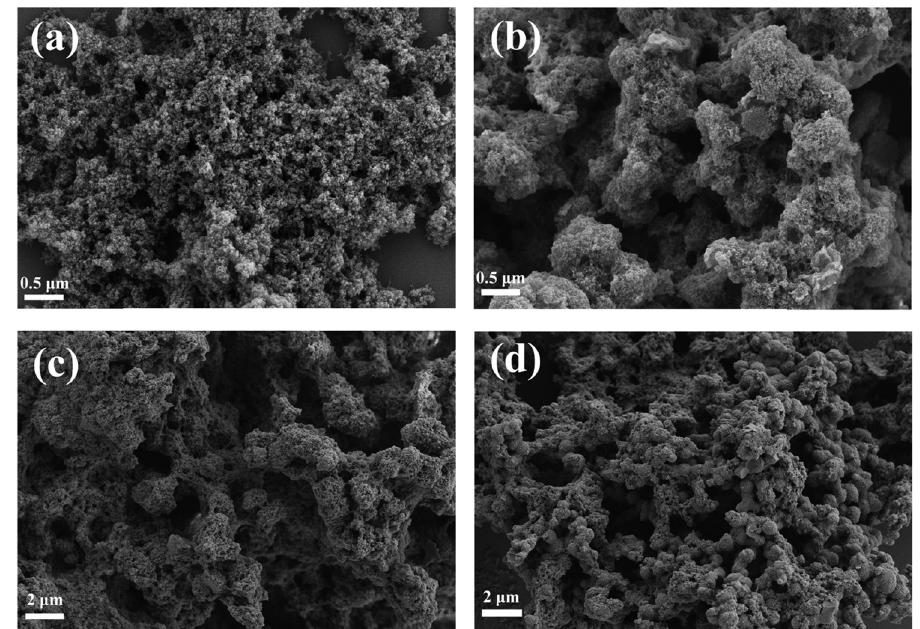
Figure 8: SEM images of HCPs prepared with the increasing amount of crosslinker: ( a ) HCP - TPB - 1, ( b ) HCP - TPB - 2, ( c ) HCP - TPB - 3, and ( d ) HCP - TPB -